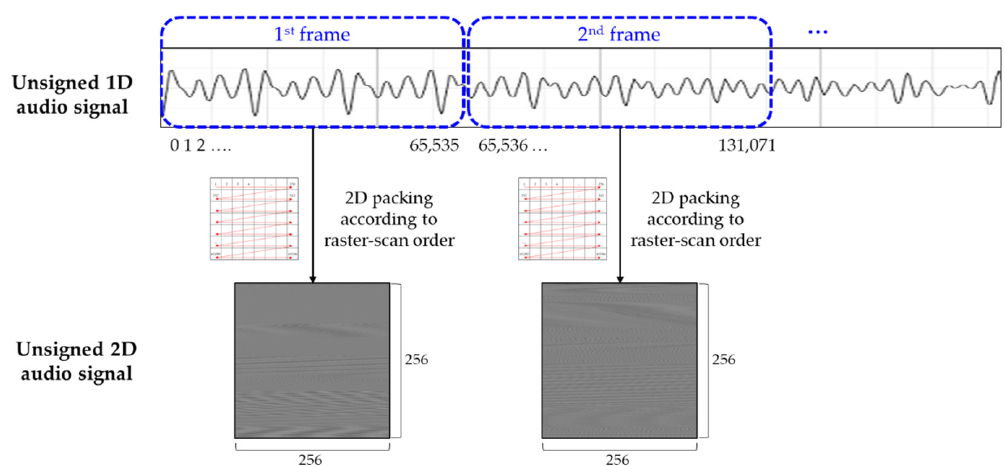
Figure 6. The 2D packing of 1D audio signals (256 × 256 spatial resolution).